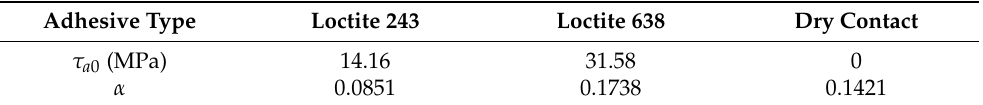
Figure 6. Shear strength as a function of the nominal contact pressure. Table 3. Coefficients of the linear regression lines for both adhesives and dry contact. Adhesive